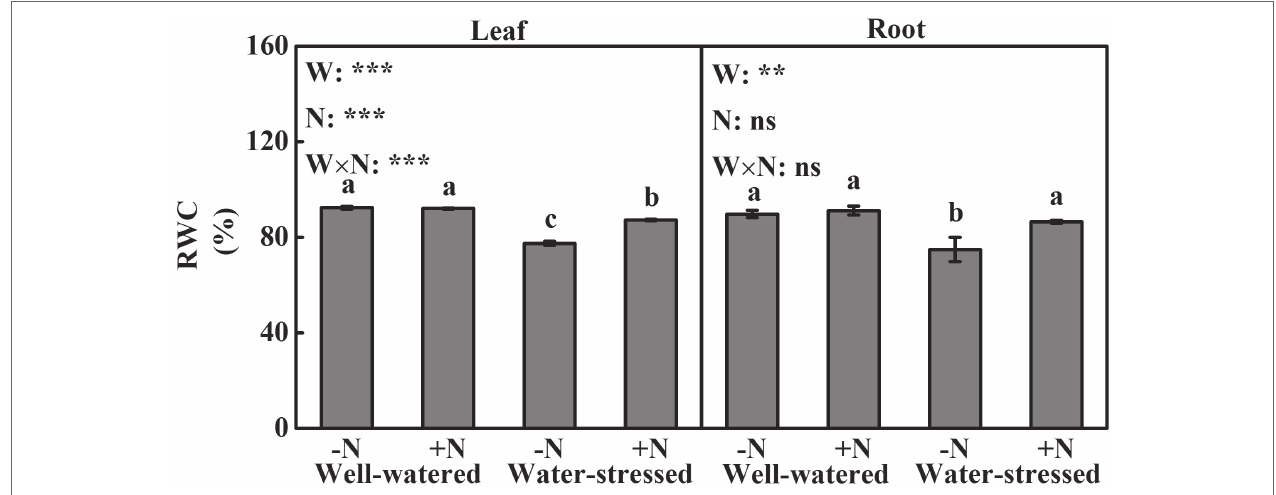
FIGURE 1 | Leaf relative water content of Fargesia denudata Yi plants for N non-deposition ( − N) and N deposition (+N) treatments with and without drought stress. F W , water effect; F N , N deposition effect; and F W × F N , interactive effect of water and N deposition. Values with different letters are significantly different at p < 0.05. Vertical bars show ± S.E. Significant levels: *** p < 0.001; ** p < 0.01; ns (non-significant) p >